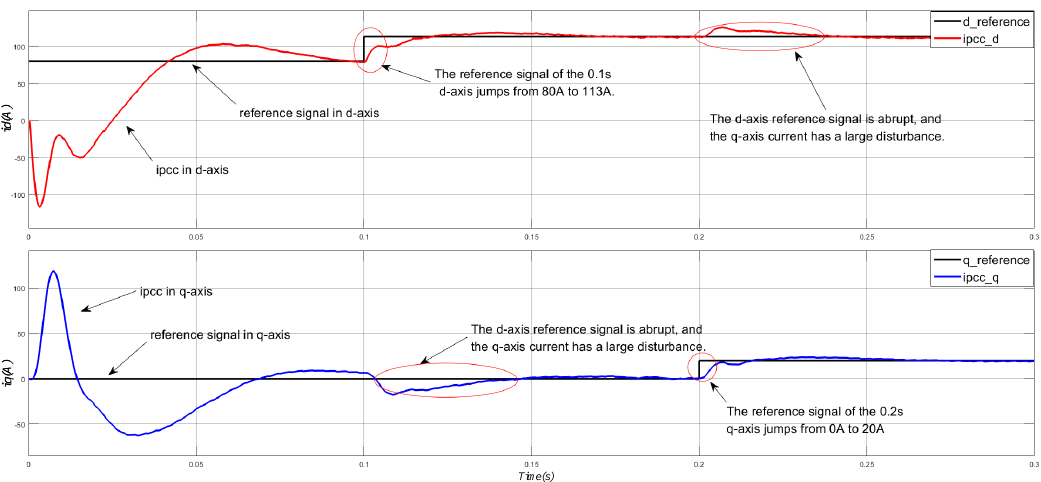
Figure 13. The point of common coupling current response curve of Scheme